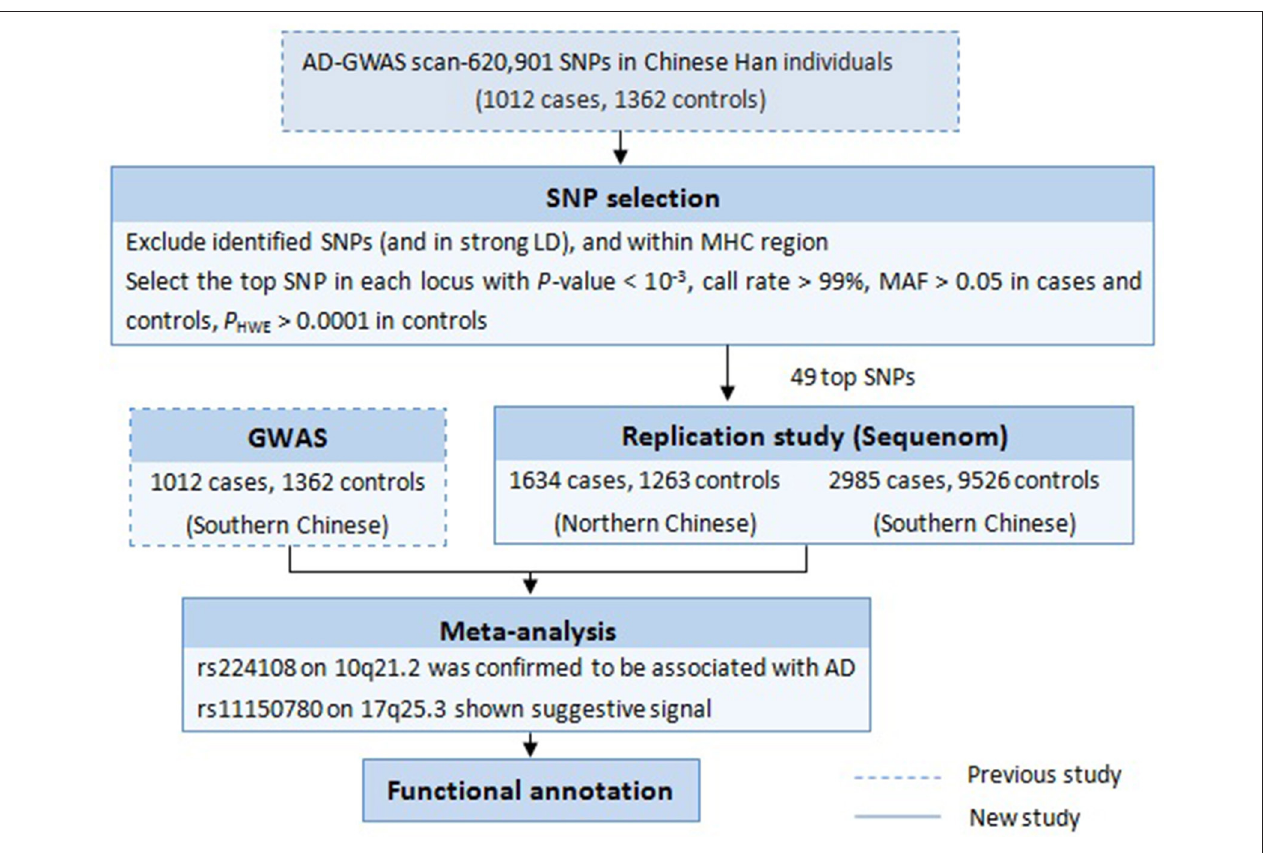
FIGURE 1 | Workflow of the study design.